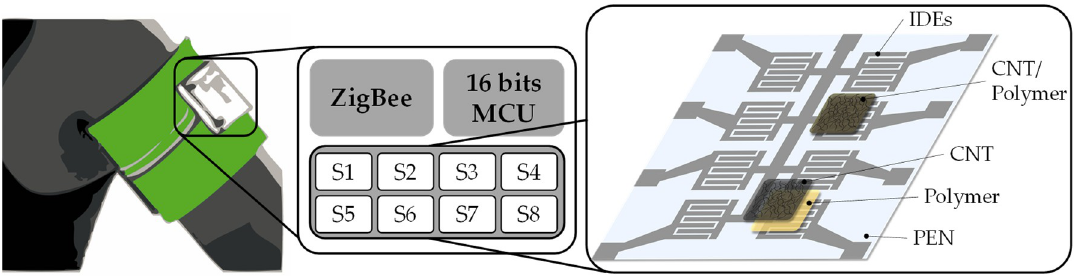
Figure 7. CNT based wireless, flexible inkjet-printed chemical sensor array [29].